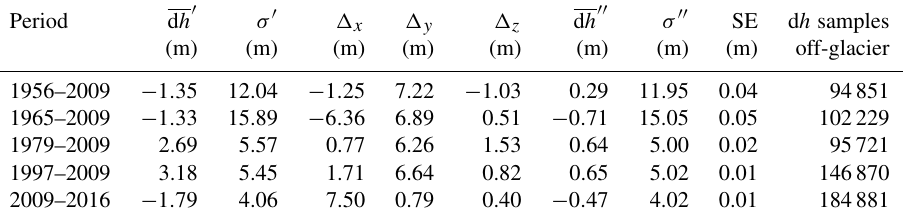
Table 2. Differences in average elevation and its standard deviation over glacier-free terrain before (d h metric adjustment, computed for the total number of elevation differences (d h samples) off-glacier for the five study periods. The geometric solution on the three axes ( (cid:49) x , (cid:49) y , (cid:49) z ) and the average standard error after adjustment (SE) are given. All the statistics are expressed in metres